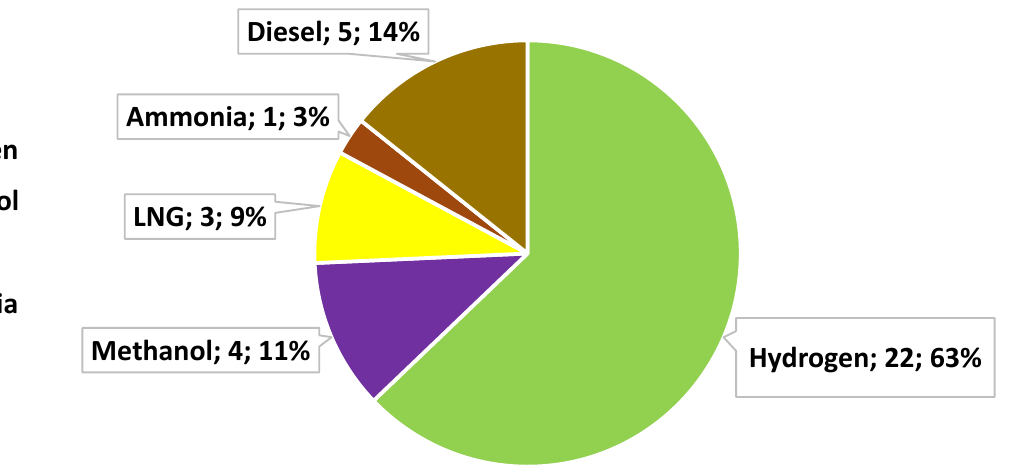
Figure 6. Number of research projects applied in the maritime industry by using different fuel cells (Data callout: Fuel cell type; number of projects, percentage).